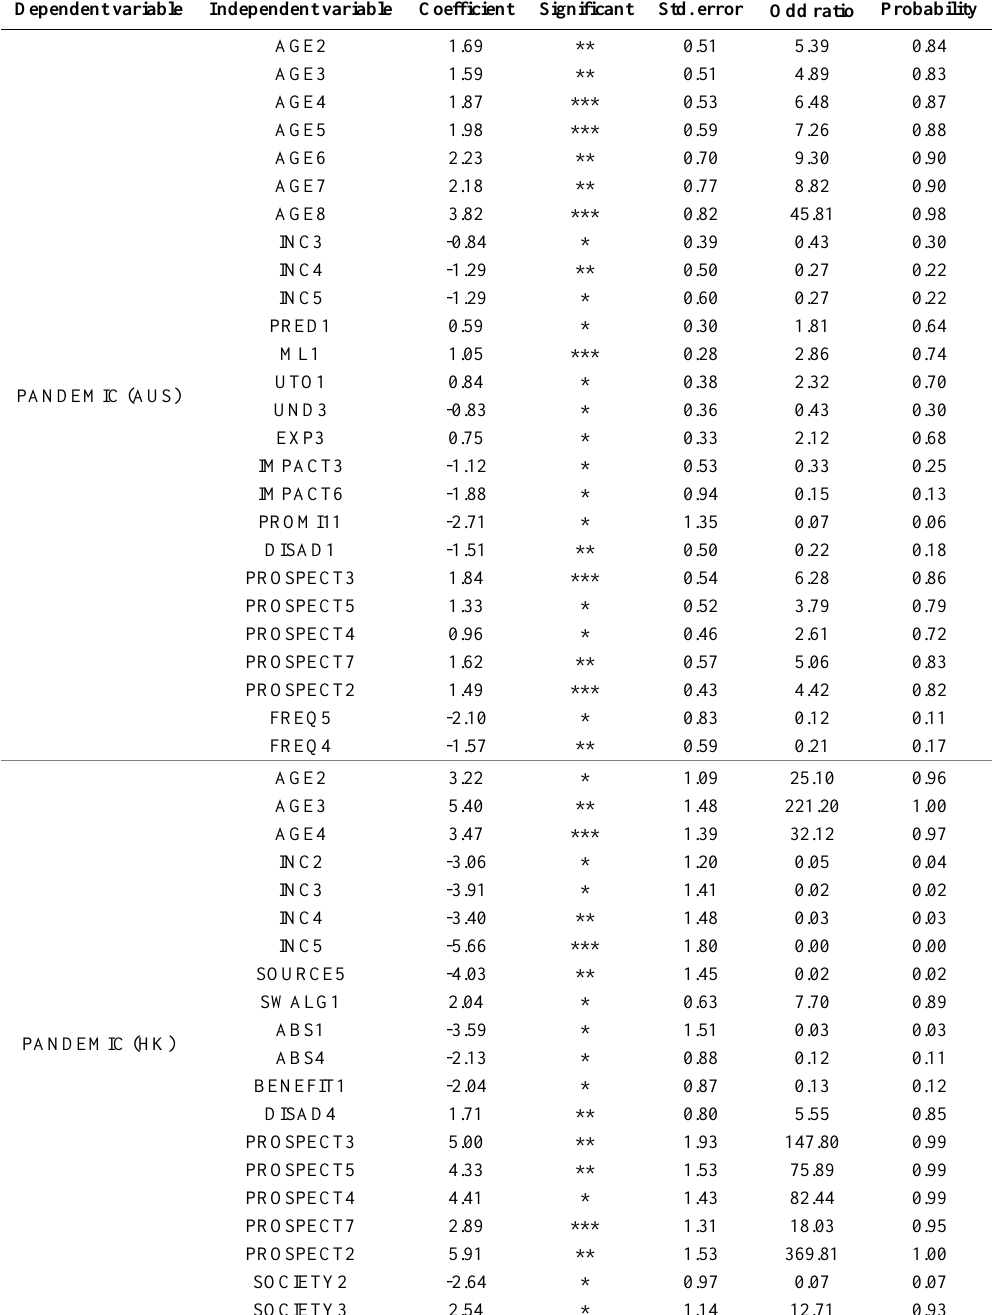
Table A-15. Pandemic monitoring and